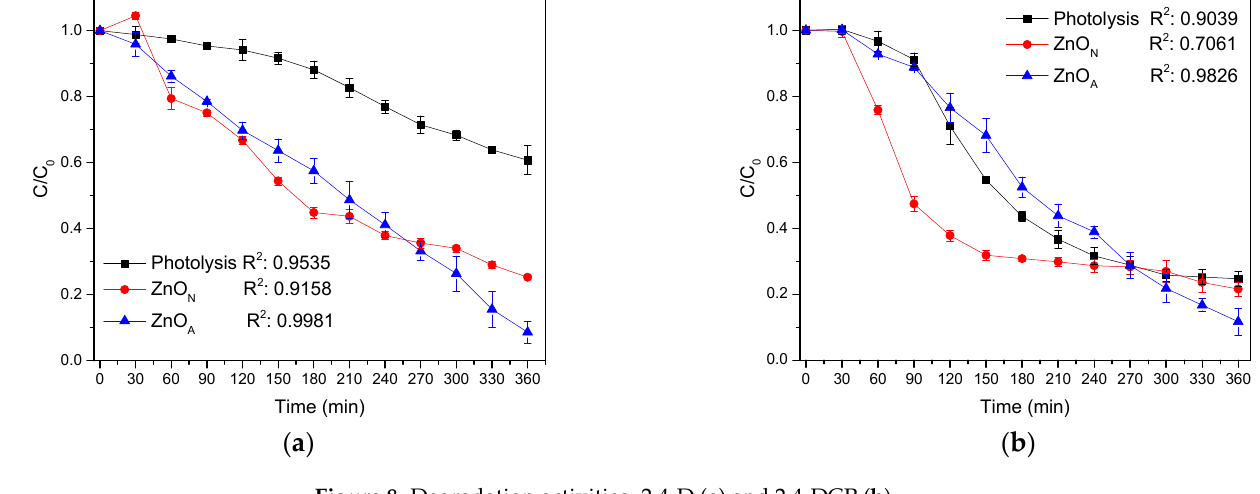
( b ) Figure 9. Experimental data and fitting assuming a pseudo-first order reaction rate: 2,4-D ( a ) and 2,4-DCP ( b ).